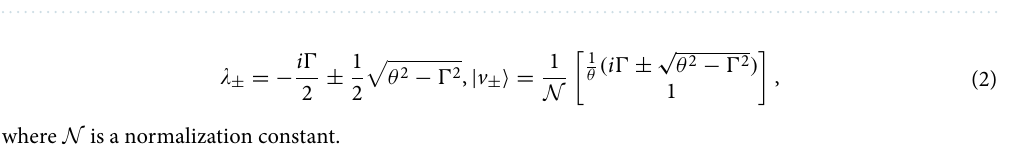
where N is a normalization constant.